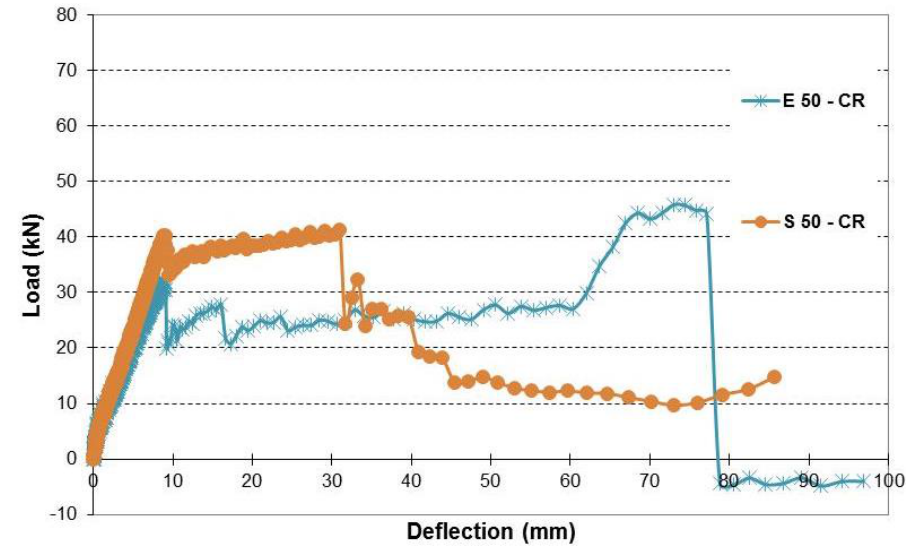
Figure 21. Load-deflection of beams with 50% corrosion levels (Repaired).